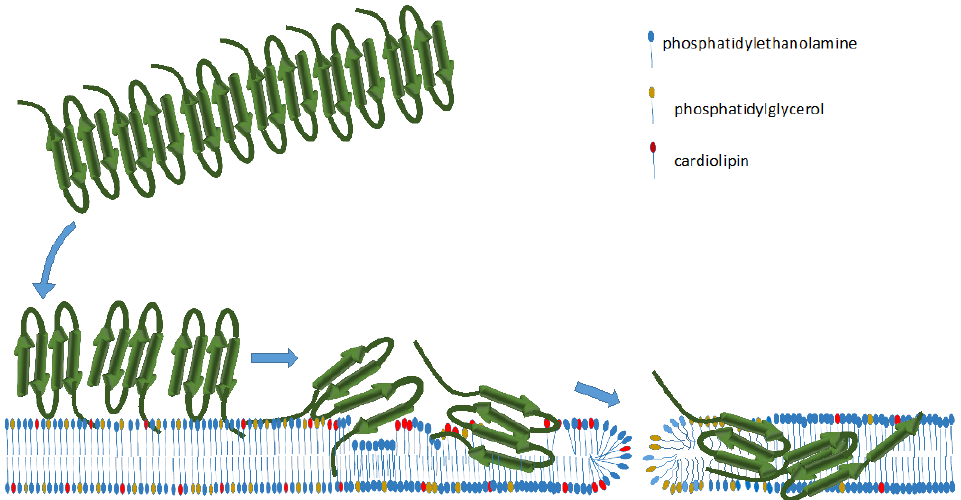
Figure 7. Model of the interaction of Hfq-CTR filaments with E. coli lipids. First, Hfq-CTR fibers interact with the membrane and then depolymerize. The first step occurs in less than 1 h, while the second step, membrane disruption and Hfq insertion, takes a few hours. The E. coli membrane contains both neutral and negatively charged lipids. Hole formation and peptide insertion most likely require the presence of negatively charged lipids, either phosphatidylglycerol (PG) or cardiolipin (CA). Our results suggest that negatively charged lipids destabilize the peptides in the filament and promote their perpendicular insertion into the membrane. This occurs with a simultaneous decrease in antiparallel β -sheet content. The stiffening of the membrane lipids is detected all along the carbon chains and, in parallel, an increase in the membrane thickness in the vicinity of the dissolved filaments occurs. As Hfq interacts mainly with polar lipid, Hfq-CTR insertion could induce phase separation of the PE and PG lipids. Hfq and sRNAs may also change E. coli membrane lipid composition [71].